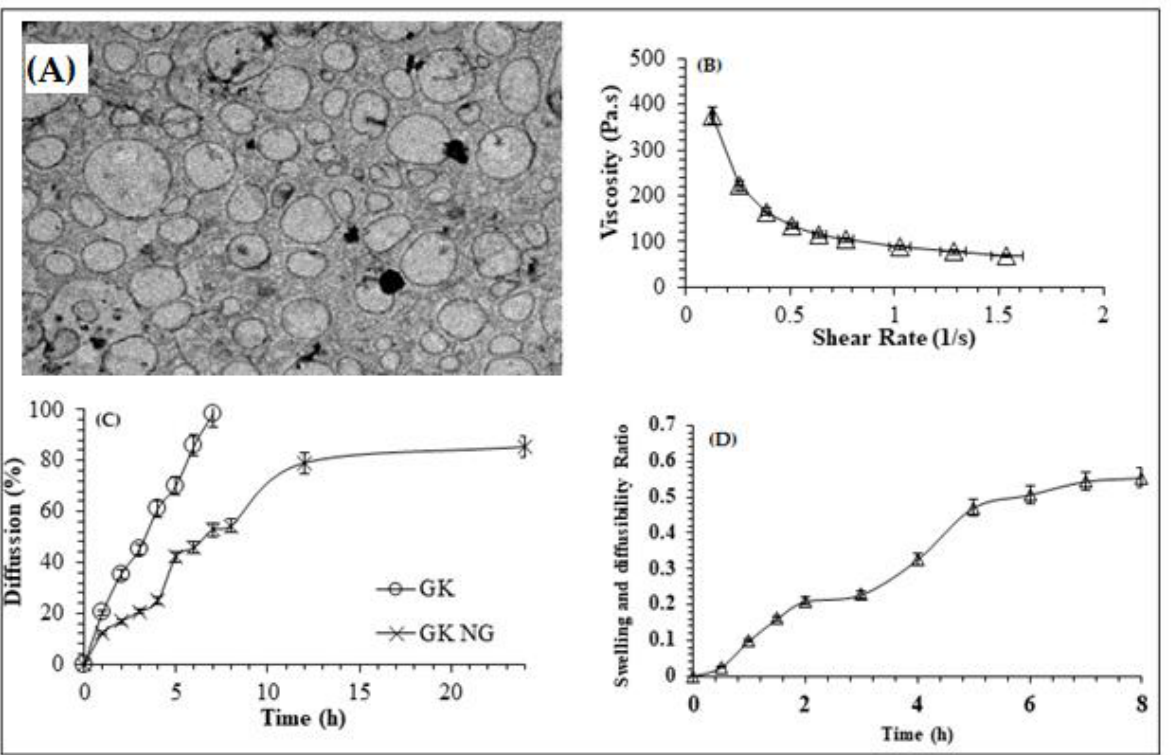
Figure 4. ( A ) TEM and viscosity ( B ) of GKNG. ( C ) Percentage diffusion of free GK and GKNG. ( D ) nanocomplex gel (GKNG) swelling, diffusibility, and resilience test over 8 h.